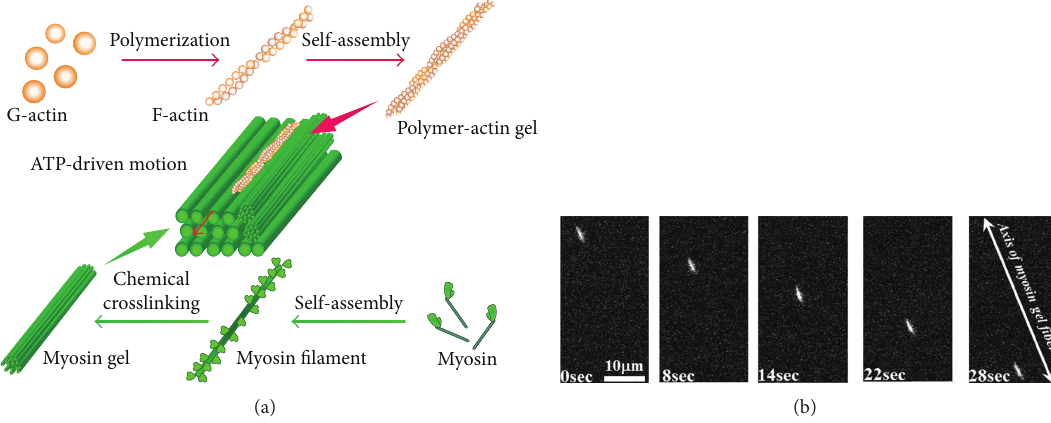
Figure 1: Scheme (a) and fluorescence images (b) of the motion of the ATP fueled actin-polymer gel actuator on the oriented myosin gel. Reprinted with permission from [20] © 2002, John Wiley & Sons,